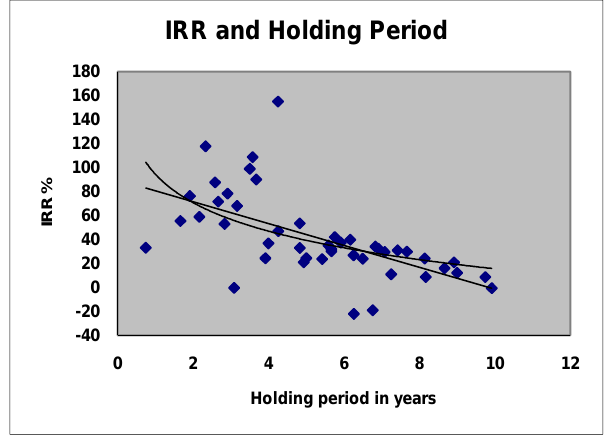
Figure 3: IRR and holding period scatter plot